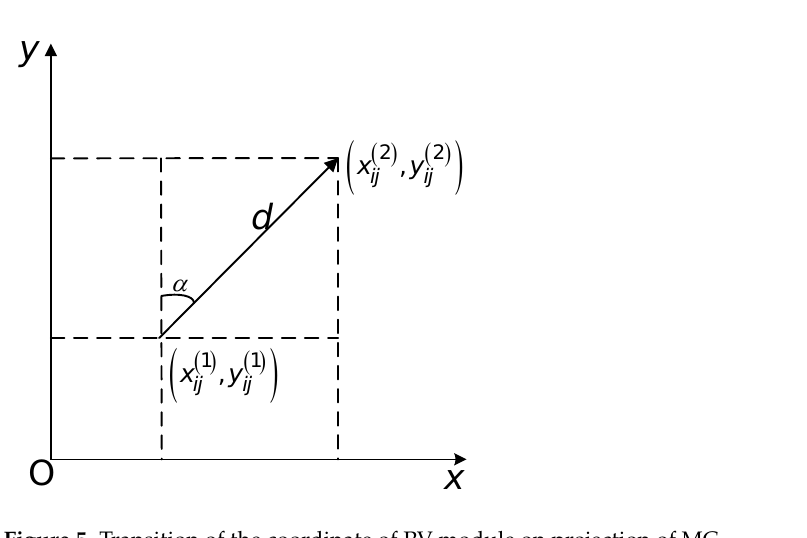
Figure 5. Transition of the coordinate of PV module on projection of